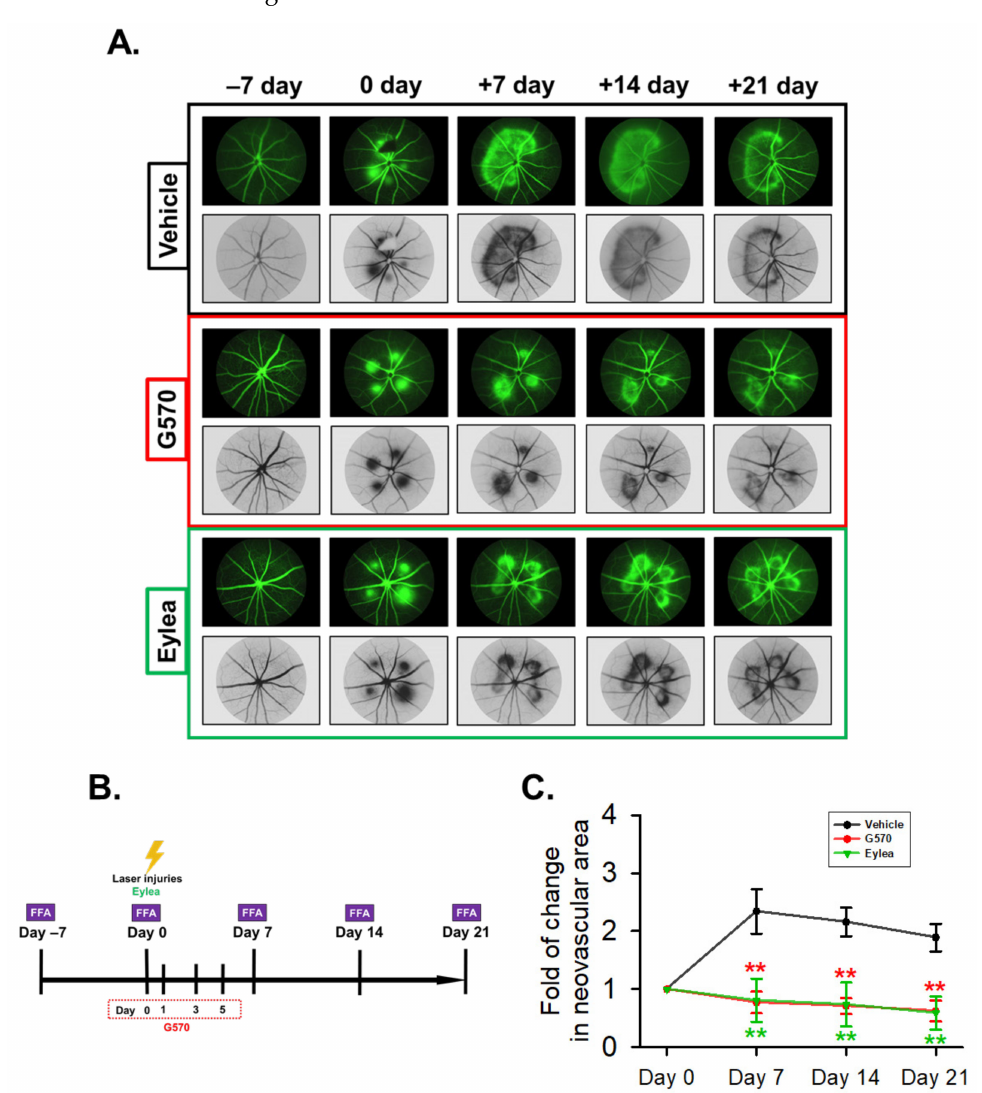
Figure 6. Effect of G570 in Laser-induced CNV model. A healthy profile of C57BL/6 mice was recorded by FFA 7 days before laser injury. Laser injury was executed on day 0. After laser injury, G570 was intraperitoneally administered (20 mg/kg per day) on days 0, 1, 3, and 5. The Eylea group, which served as the positive control, was treated by intravitreal injection (40 µ g/1 µ L per eye) on day 0. FFA was recorded at days − 7, 0, 7, 14, and 21. ( A ) FFA figures of C57BL/6 mice. ( B ) Flow chart of laser-induced CNV experiment. ( C ) Fluorescein leakage fold of each group. The leakage area was evaluated. Data are expressed as the mean ± S.D. and were obtained in triplicates. Significance was estimated compared to the vehicle. p ** ≤